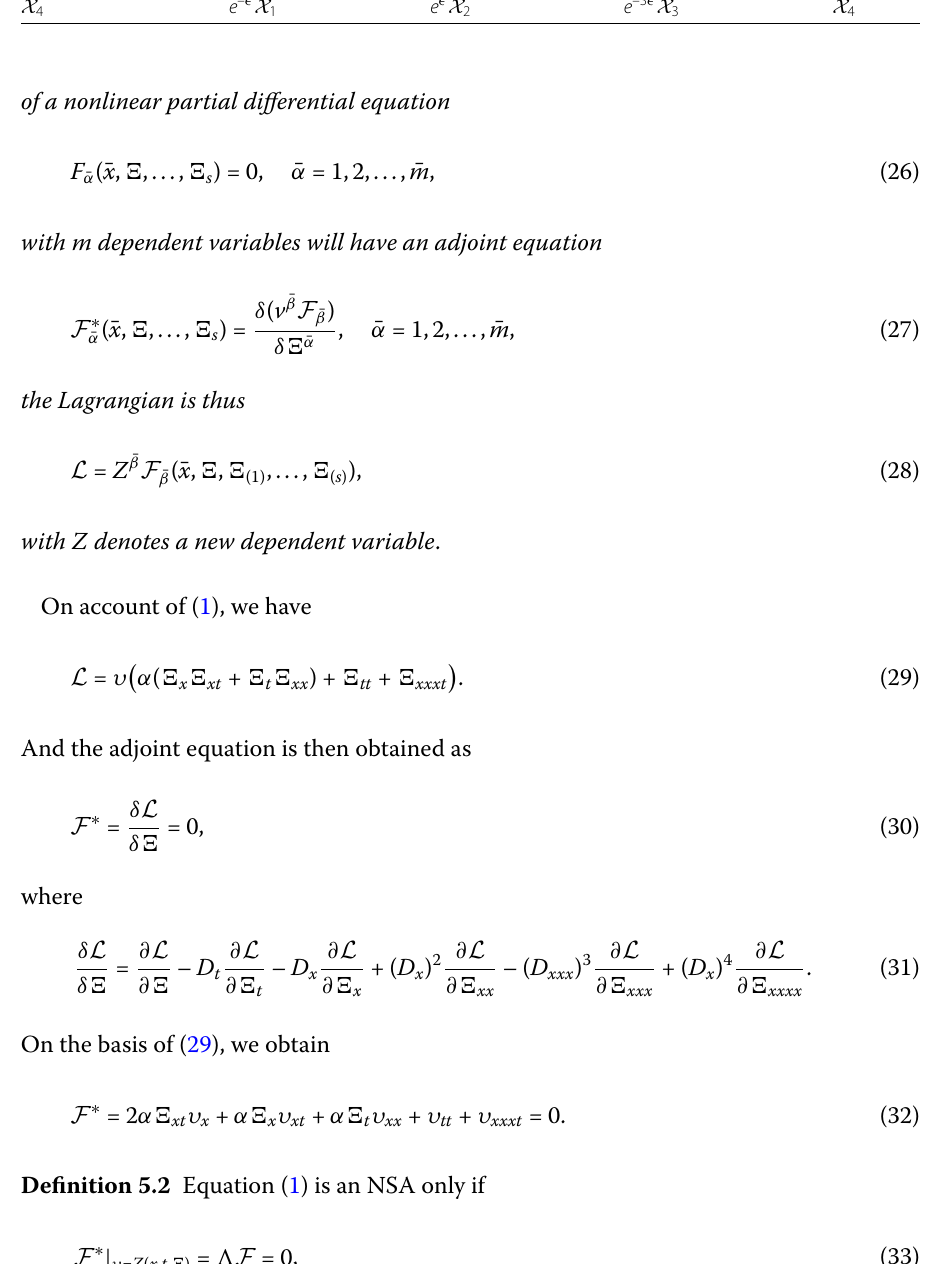
Table 2 The commutation relations of infinitesimal generators X 1 , X 2 , X 3 [ X i , X j ] X 1 X 2 X 3 X 4 X X 1